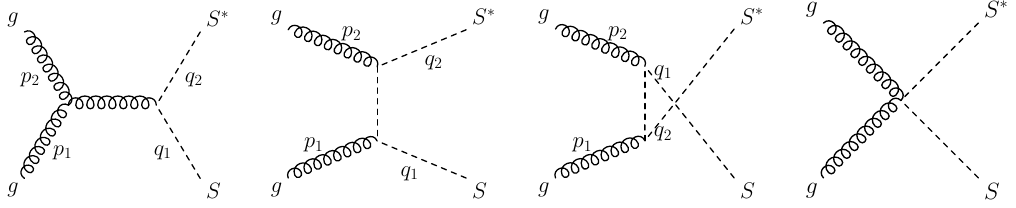
Figure 6 . Feynman diagrams for the LO scalar pair-production at hadron colliders via gluon